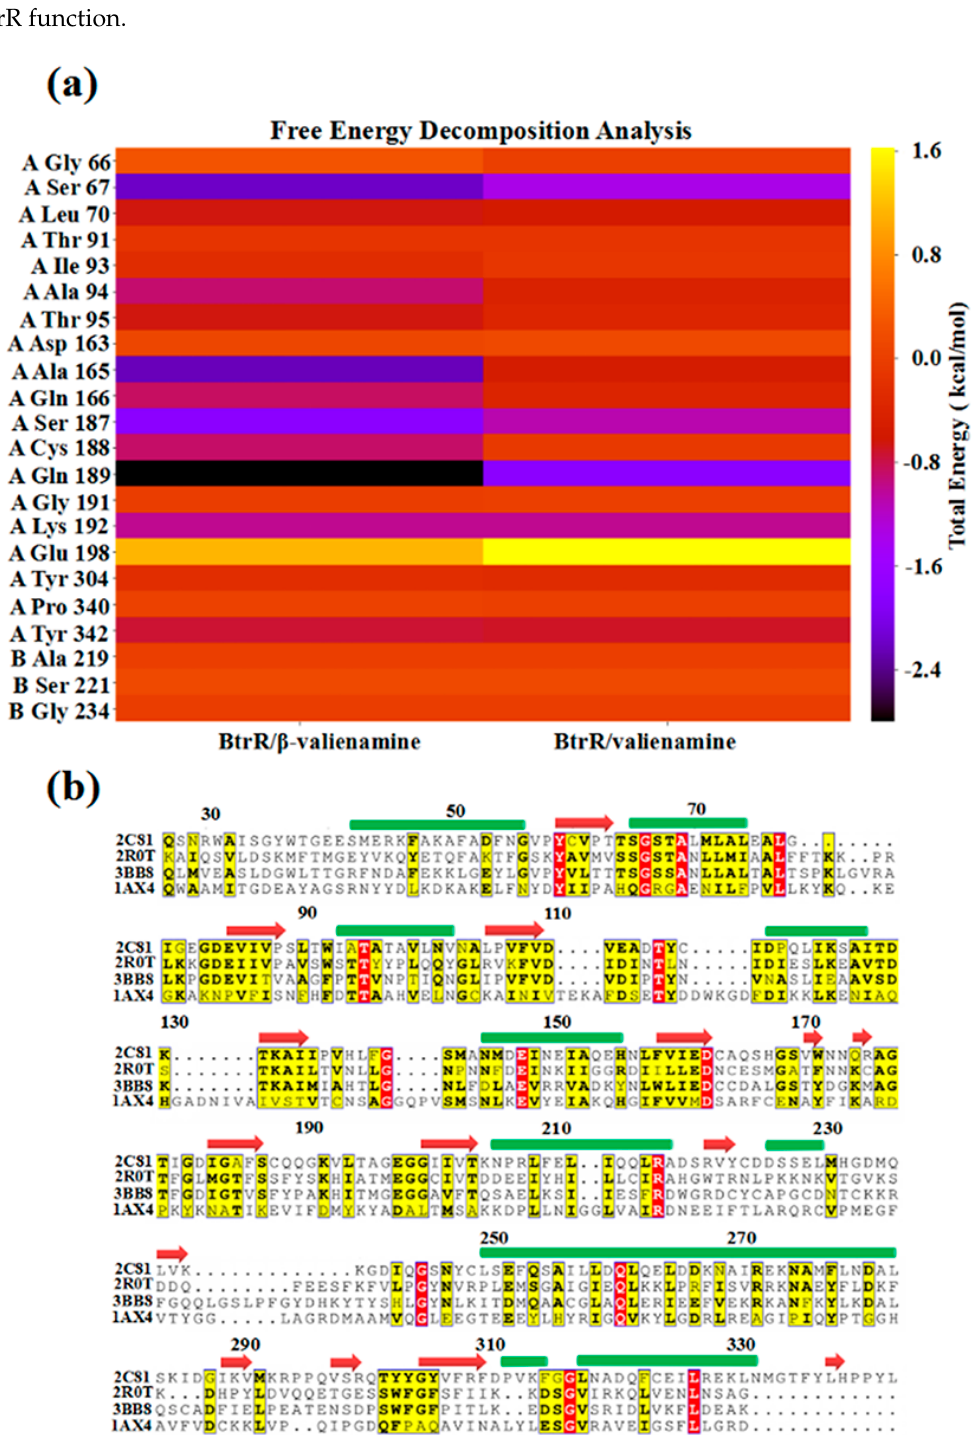
Figure 5. Free energy decomposition analysis for the BtrR/ β -valienamine and BtrR/valienamine complexes. ( a ) The total energy for residues (calculated using MM-GBSA). ( b ) Homologous sequence correlation for PDB ID 5W71 (BtrR), 2R0T, 3BB8, and 1AX4. The residues are highlighted in red and yellow, which correspond to high homology.